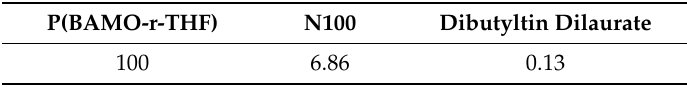
Table 1. Composition (mass ratio) of P(BAMO-r-THF)